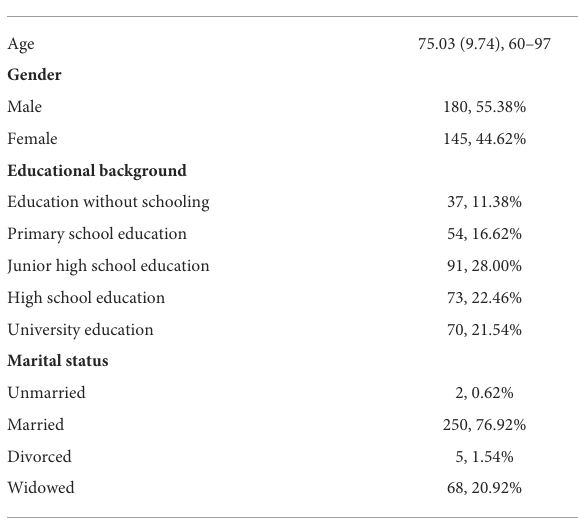
TABLE 1 Demographic characteristics of the functionally impaired elderly ( n =